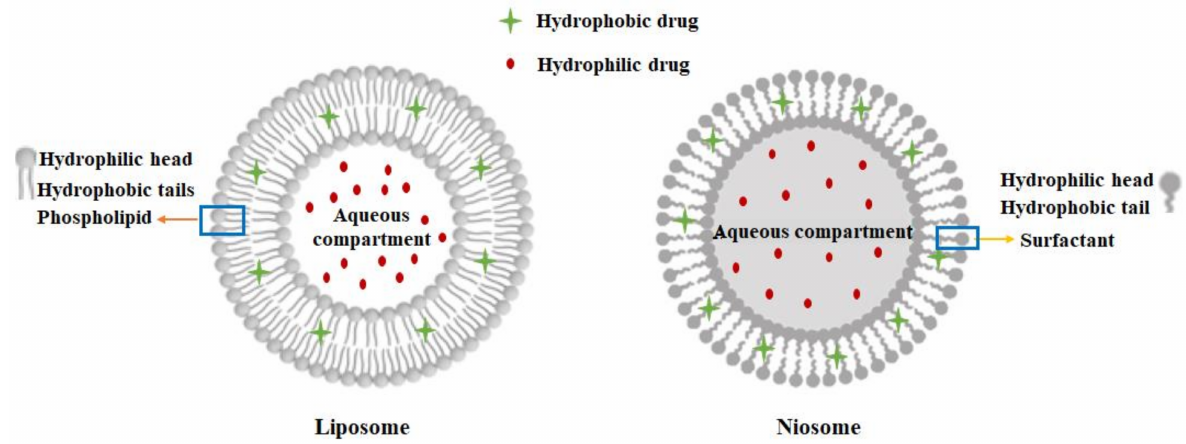
Figure 1. The similarity and differences of liposomal and niosomal structures. These are spherical nanostructures with bilayer membranes that have the capability of delivering both hydrophobic and hydrophilic therapeutic agents. However, niosomes are composed of surfactants, which are cheaper than